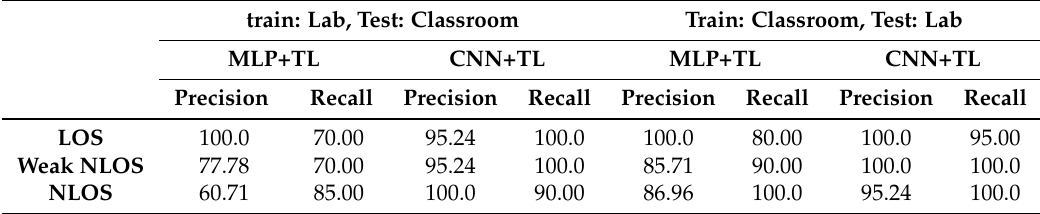
Table 5. UWB channel classification performance of transfer learning to the MLP and transfer learning to the CNN in different unmeasured